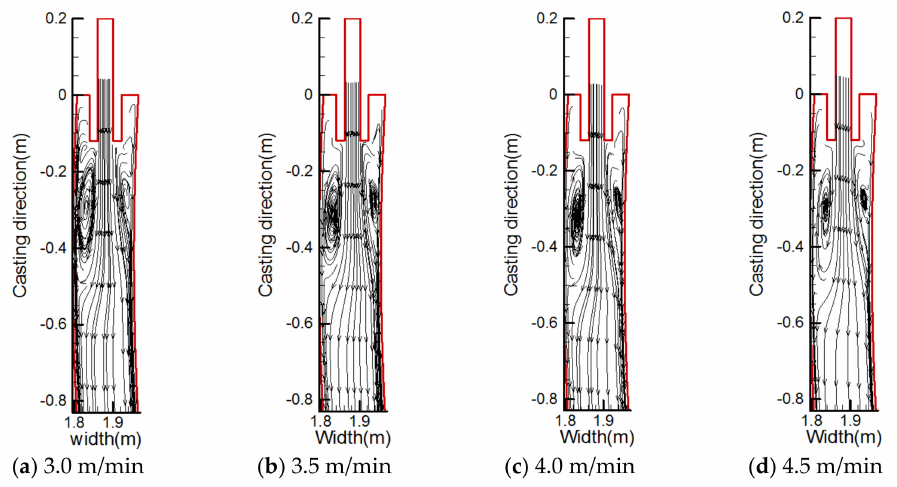
Figure 9. Flow field trace diagram of mold central symmetry plane at different casting speeds.